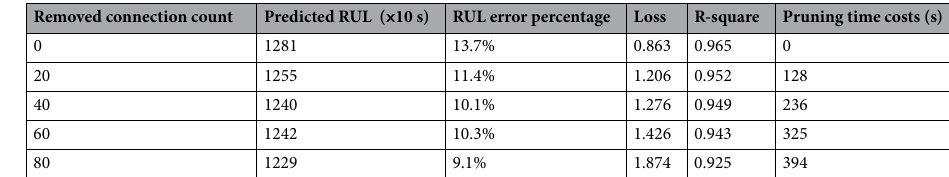
Table 12. Pruning results comparison for RUL